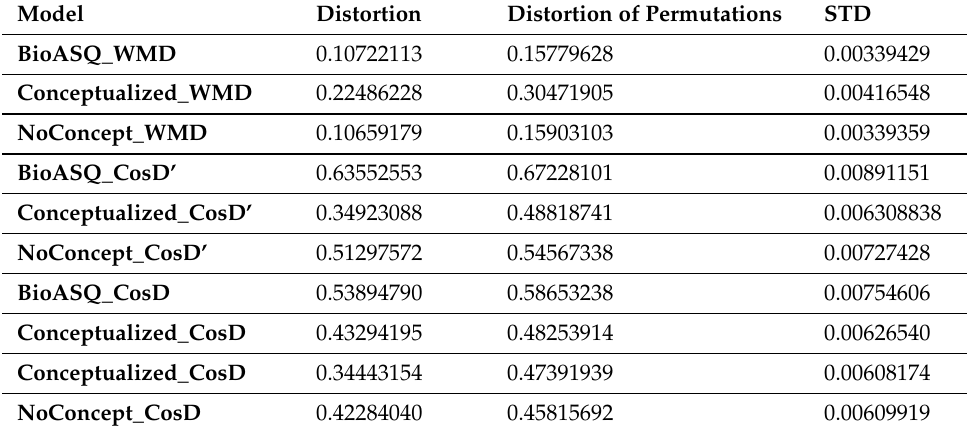
Figure A1. For the graphs of the eight hypertension guidelines and their abstracts a visual comparison is more difficult than it was earlier in Figure 5. Therefore, we need a quantitative comparison, which is given in Table A5. Table A5. We see the robustness of the proposed method when comparing the conceptual distances of the abstracts and the full documents of the hypertension guidelines. The results are in line with those of Section